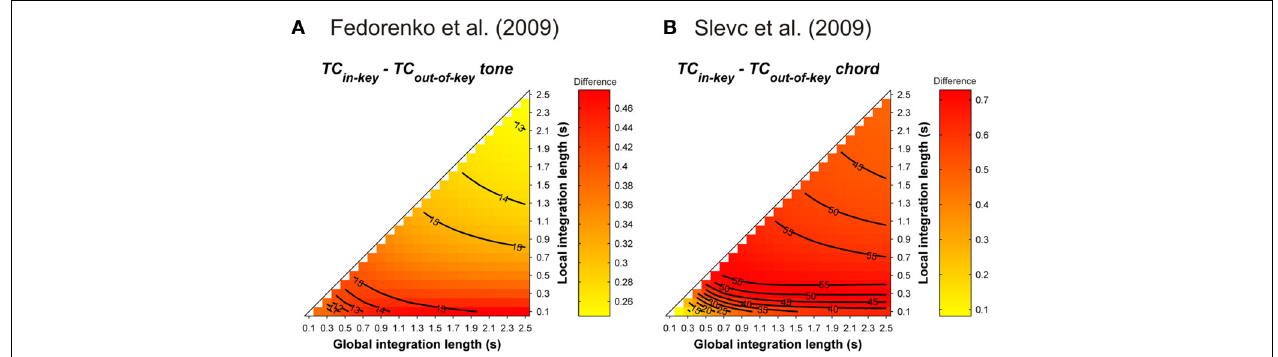
FIGURE 13 | Mean TC differences between tonic vs. out-of-key tones (A, Fedorenko et al., 2009) and tonic vs. out-of-key chords (B, Slevc et al., 2009), as a function of the local and global context integration windows.